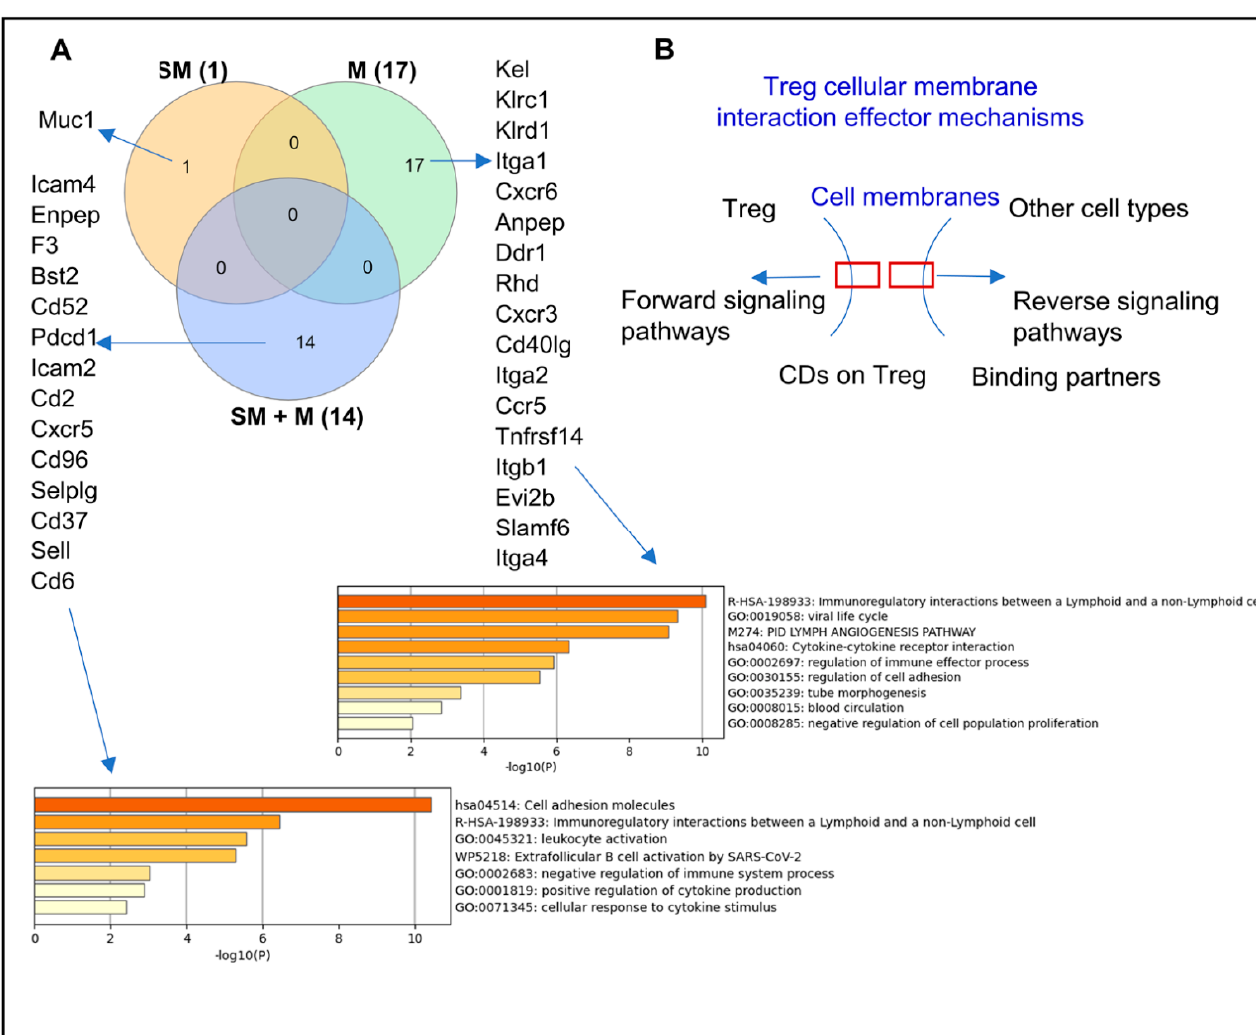
Figure 4. Cell adhesion molecules and leukocyte activation are the CD molecular pathways upreg- ulated in cigarette smoke plus morphine (SM + M) treated Tregs. ( A ) The Venn diagram analysis showed that SM + M, morphine (M), and cigarette smoke (SM) specifically upregulated the expres- sions of 14, 17, and 1 cluster of differentiation (CD) respectively after screening for a total of 373 CDs in mouse splenic CD4 + Tregs. The SM + M upregulated CD group has 7 signaling pathways while the M upregulated CD group has 9 signaling pathways. ( B ) The schematic figure showed the CDs on Treg and the forward signaling pathway, and on the other cell types with a reverse signaling pathway.